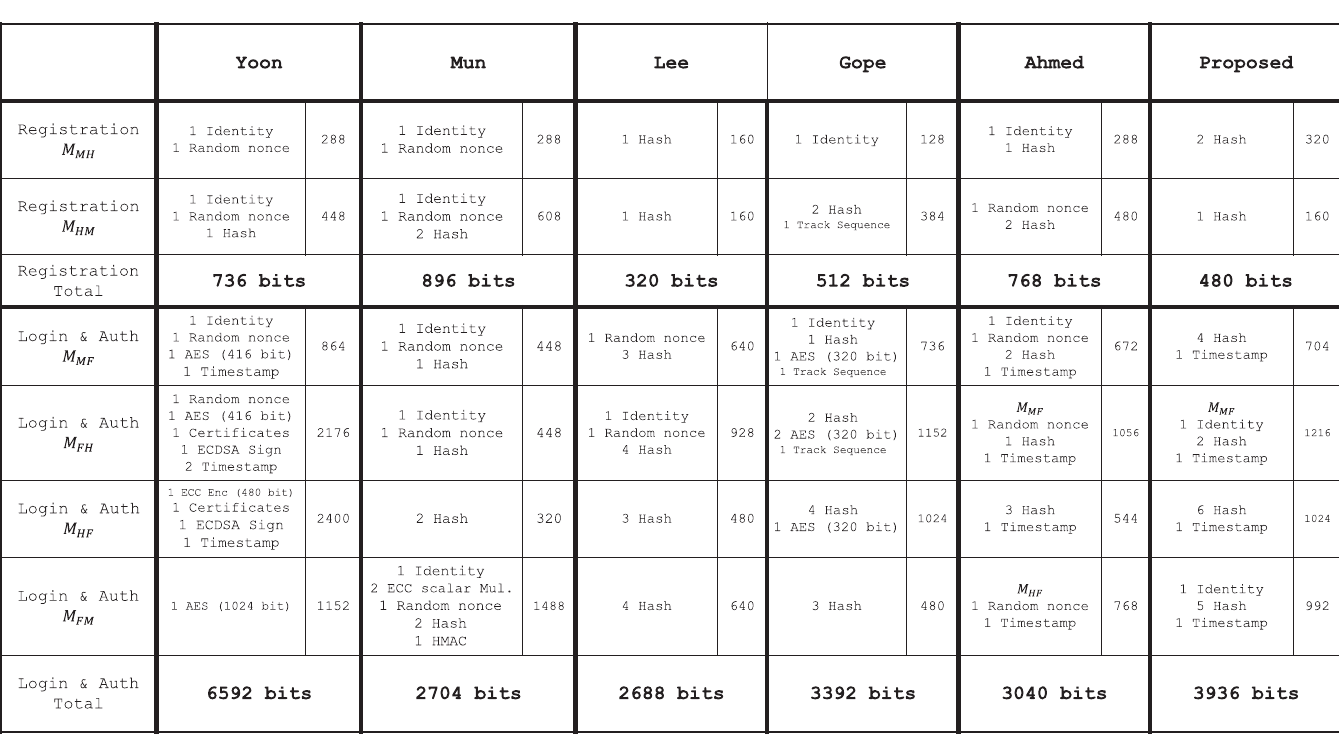
Fig 21. Detailed analysis by each communication message between our proposed scheme and existing